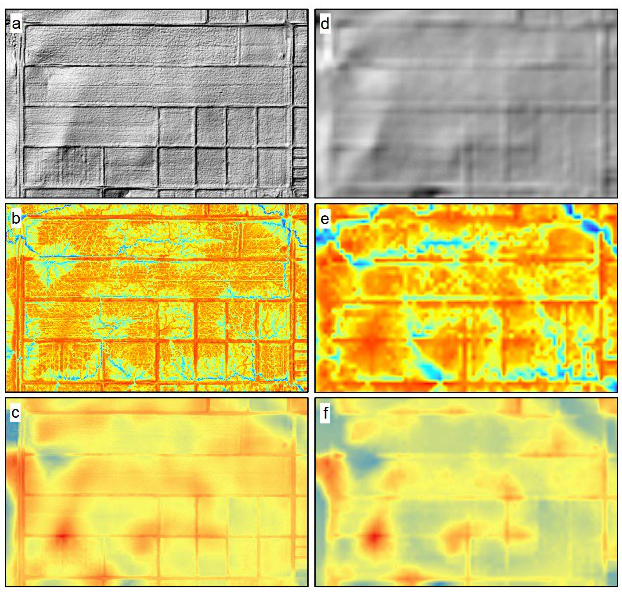
Figure 2. The hillshade ( a ) topographic wetness index ( b ), and topographic position index ( c ) from the 1.5 m lidar DEM. The hillshade ( d ) topographic wetness index I, and topographic position index ( f ) from the 10 m resample lidar DEM.